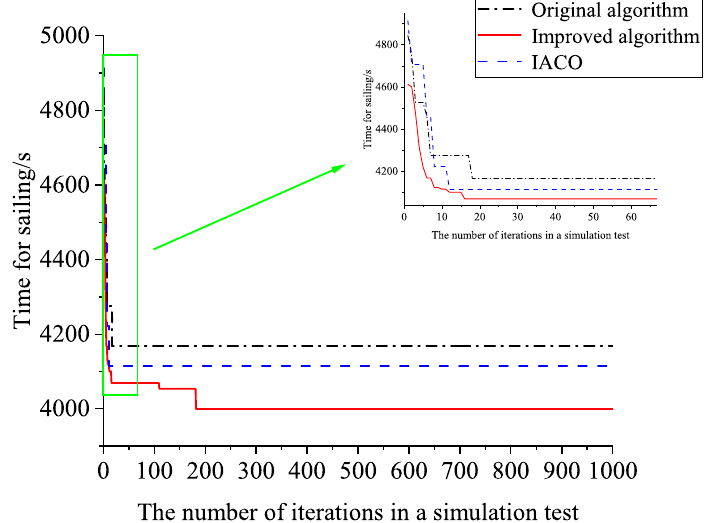
Figure 9. Convergence situation before and after algorithm